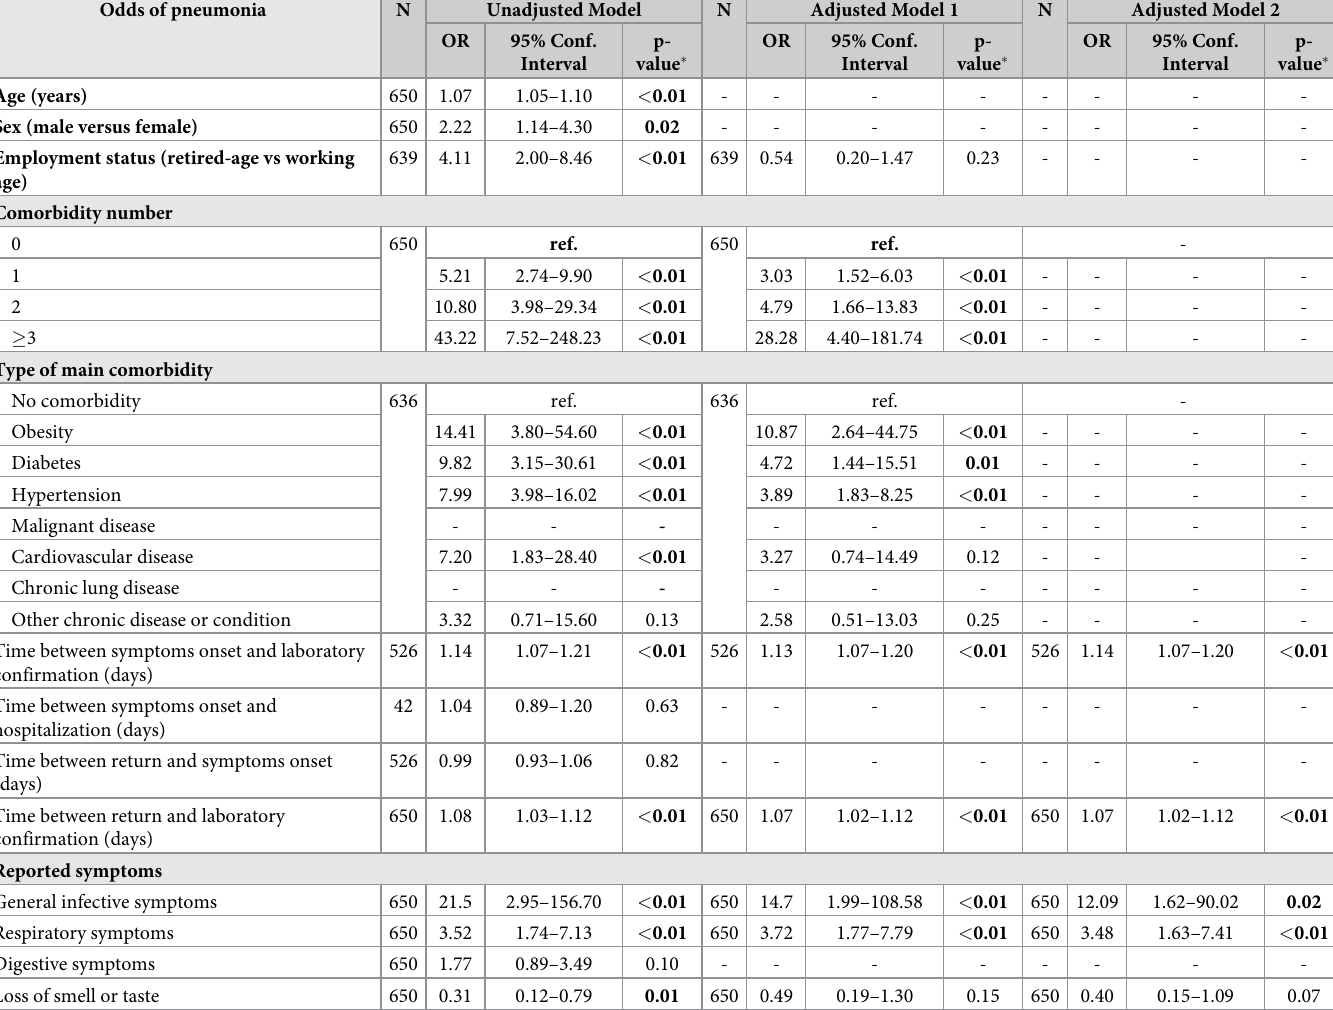
Table 4. Predictors of pneumonia (severe and critical disease) in travel-associated cases of COVID-19 in Vojvodina, Serbia, in the period March 6—December 31,